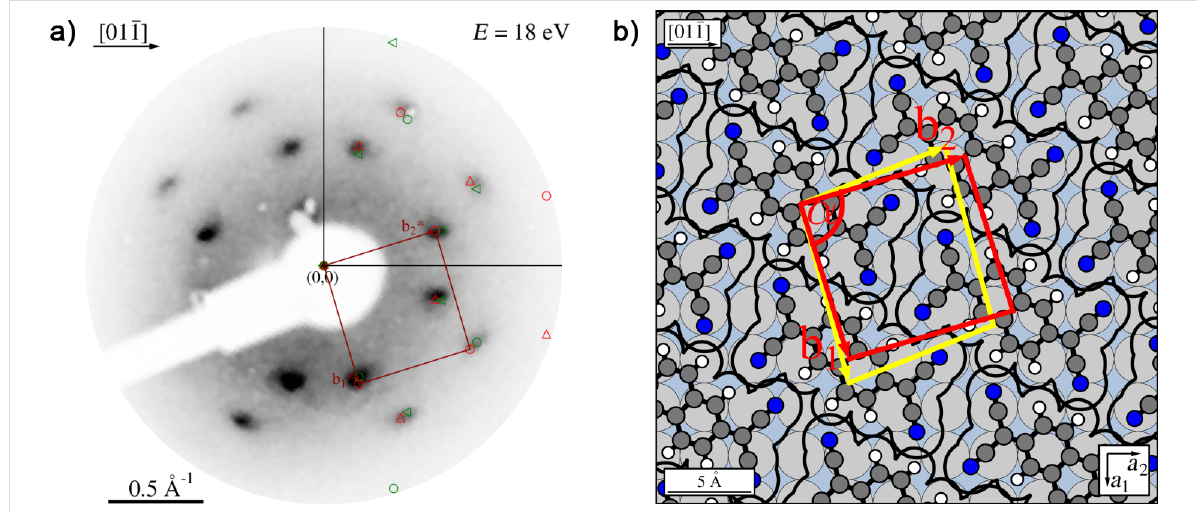
Figure 5: Multilayers of TNAP on Ag(100). (a) LEED pattern recorded at an electron energy of 18 eV. A simulated diffraction pattern is overlaid. Symmetry-equivalent domains are marked as in Figure 2. (b) Hard-sphere model of the TNAP multilayer (red unit cell); in addition, the unit cell of the TNAP monolayer (yellow) has been